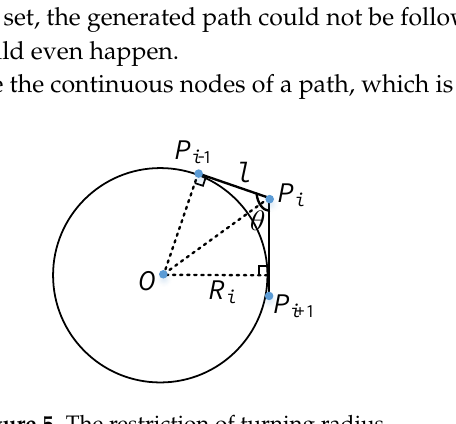
Figure 5. The restriction of turning